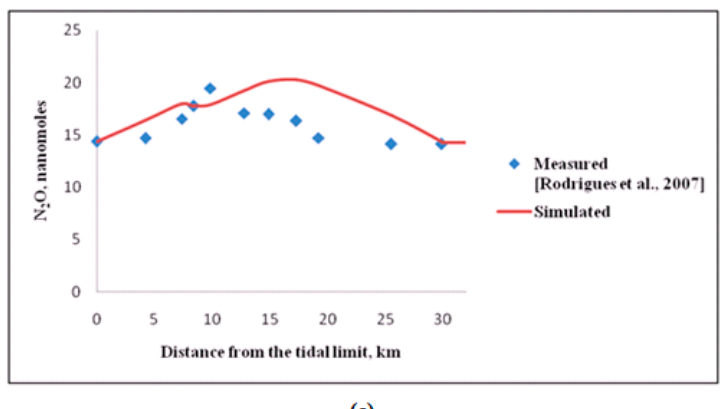
Figure 2. Comparison of current Simulations (continuous lines) and field measured values from Rodrigues et al, 2007 (solid diamonds) [26] of longitudinal profiles of mean monthly concentrations of: ( a ) NH 4 + , ( b ) NO 3 − , and ( c ) N 2 O for August 2000 in Tyne river.